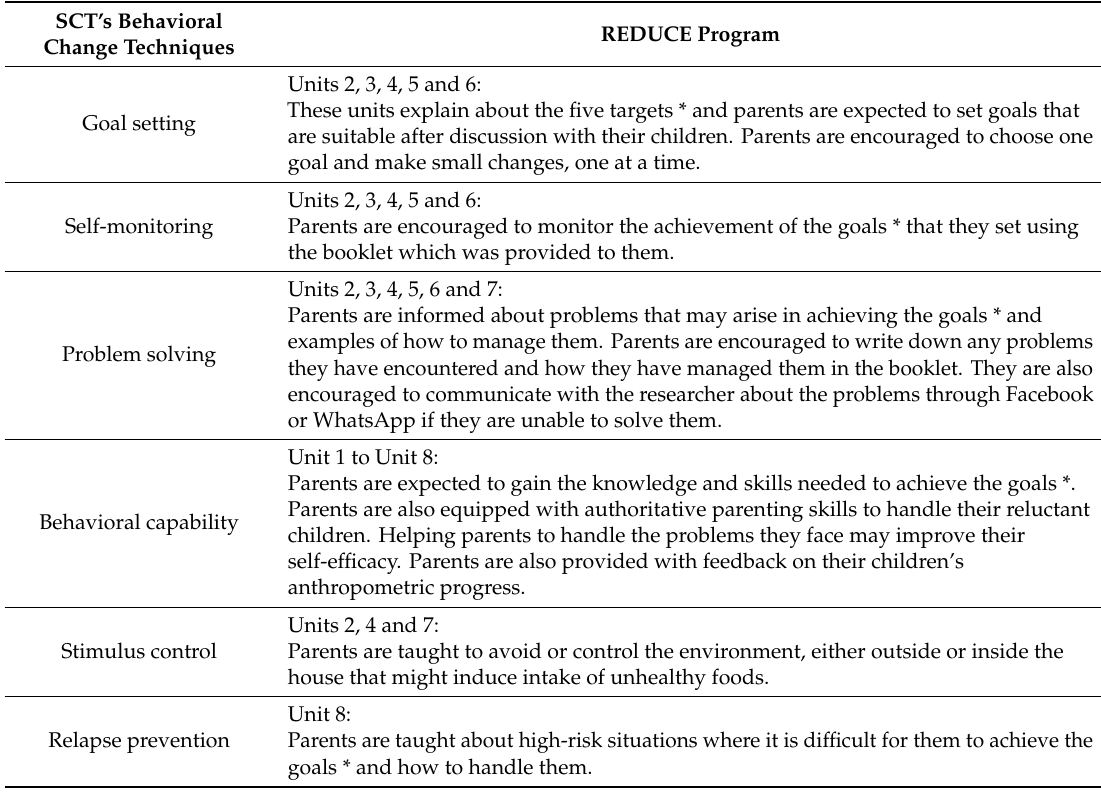
Table 2. The application of Social Cognitive Theory (SCT)’s behavior change techniques in the REDUCE